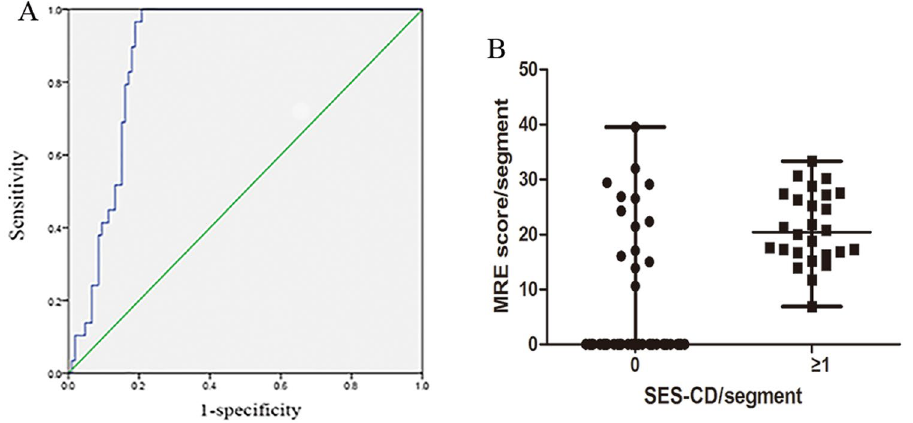
Figure 2. ( A ) Receiver operating characteristic (ROC) curve of MRE score for each segment in predicting endoscopic mucosal healing. The area under the curve was 0.881 (95% confidence interval (CI): 0.825–0.937); ( B ) MRE score/segment in the endoscopic mucosal healing group (SES-CD = 0) and the active mucosa group (SES-CD ≥ 1). The horizontal line in the middle is the median, and the lower line represents the lower quartiles, while the upper line represents the upper quartiles.